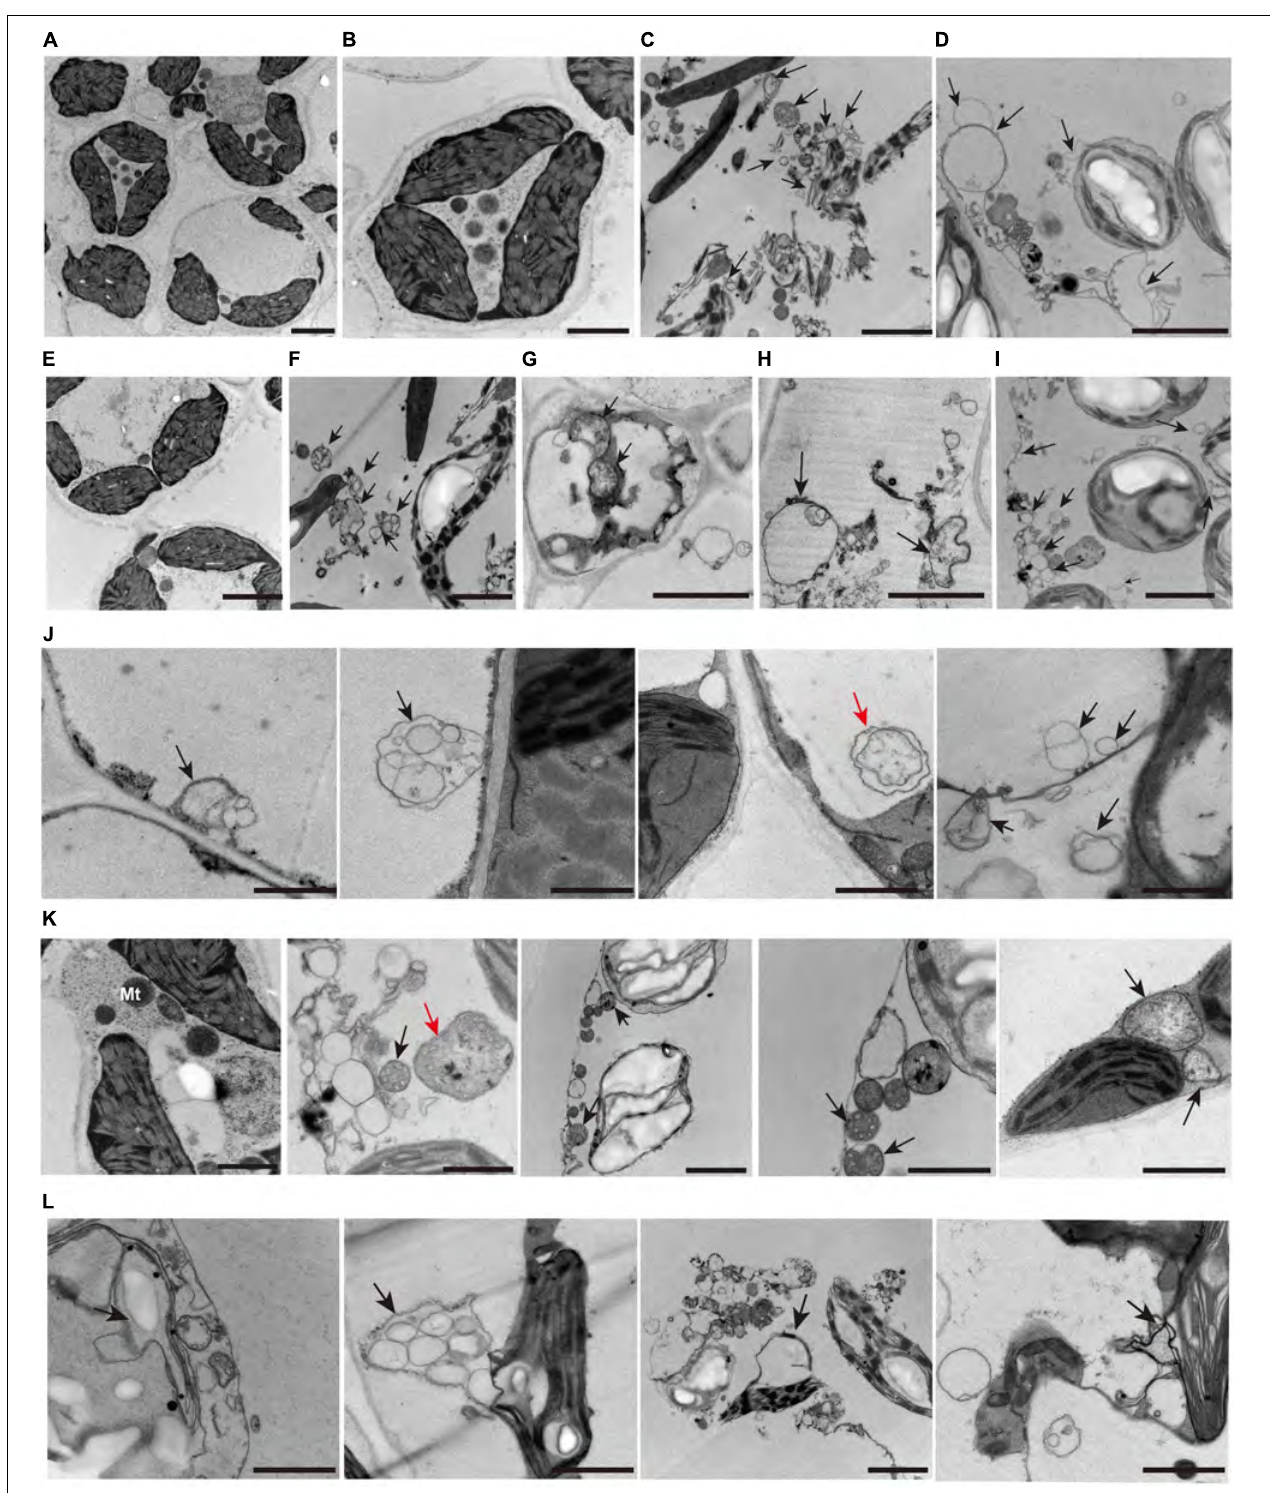
FIGURE 11 | Representative transmission electron microscope (TEM) images of autophagosome structures. (A–I) Representative ultrastructure of autophagosomes (arrows) observed of mesophyll cells of wild-type ZJ22 (A,B,E) and mutants zj-es (C,D,F–I) . (J) The plasma membrane was involved in the formation of autophagosomes (arrows). (K) The mitochondria were involved in the formation of autophagosomes (arrows). (L) The chloroplast membrane was involved in the formation of autophagosomes (arrows). The red arrows show the classic double-membrane autophagosomes.